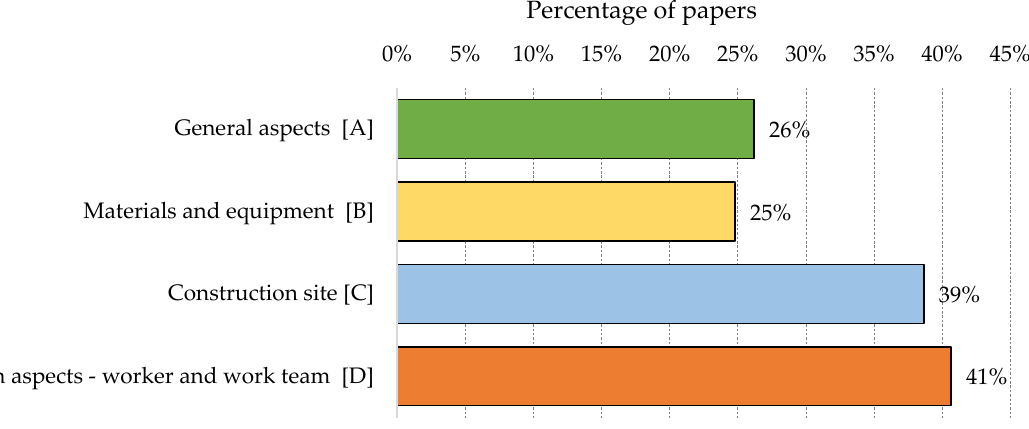
Figure 5. Percentage distribution of factors in each of the four categories.